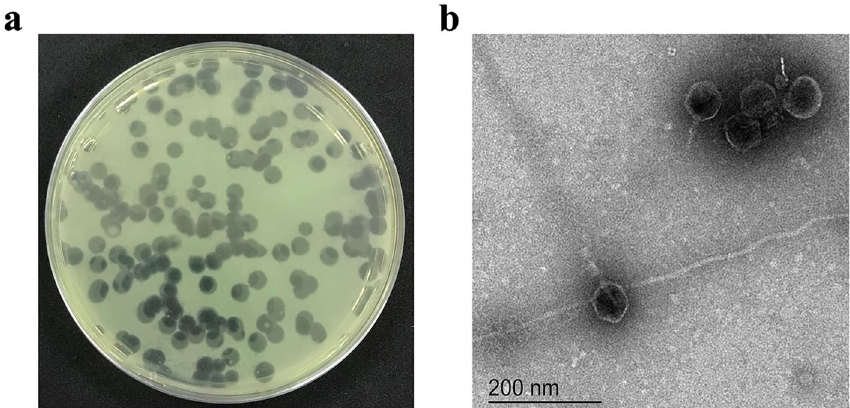
Figure 1. Plaque and morphology of the phage vB_PaeS_VL1. ( a ) Plaque morphology of phage VL1 formed in double-layer agar plate with P. aeruginosa ATCC27853 as host strain. ( b ) Transmission electron micrographs of phage VL1 negatively stained with 2% (w/v) uranyl acetate. The scale bar represents 200